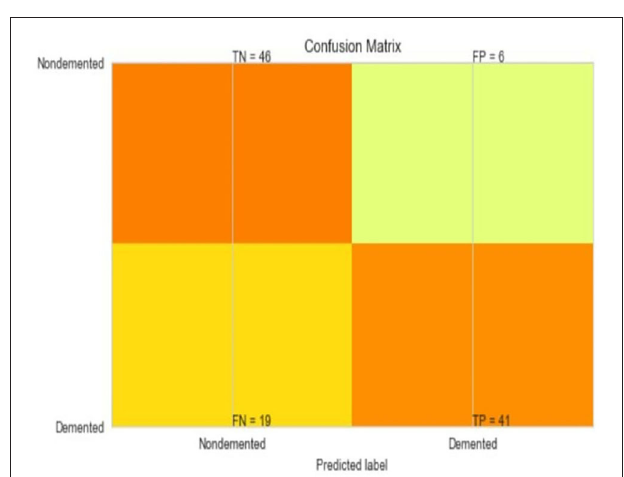
FIGURE 9 | Confusion matrix for random forest.